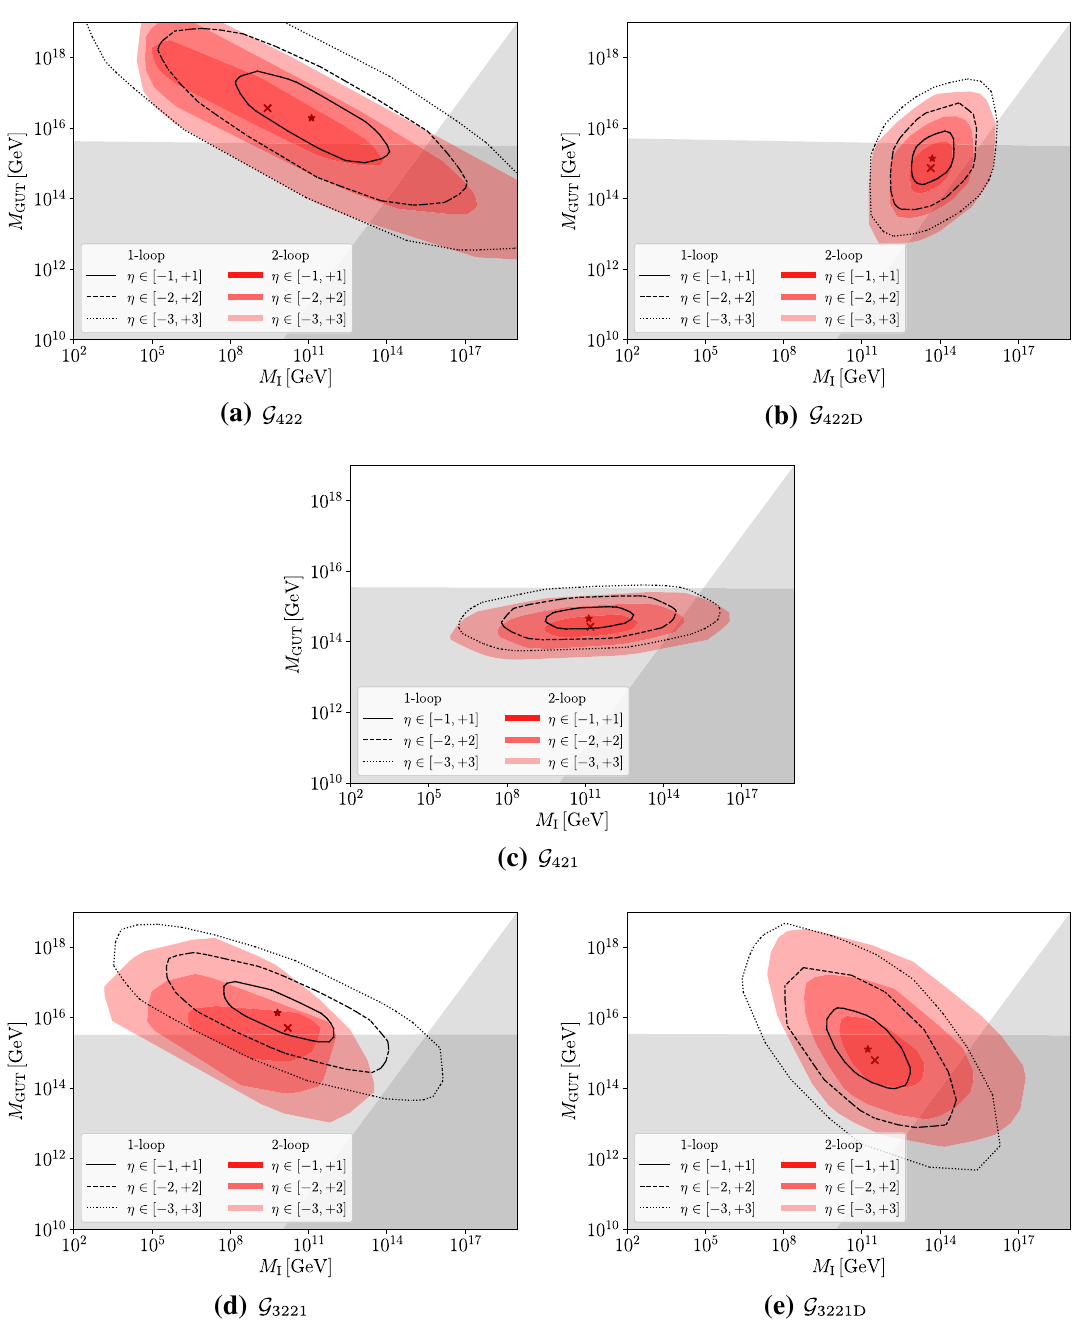
η ∈ [− 1 , + 1 ] , [− 2 , + 2 ] , and [− 3 , + 3 ] , respectively. The scales i without threshold corrections are marked with a “ × ” (“ (cid:12) ”) for the two- loop (one-loop) result. The grey shaded regions are forbidden by a too short proton lifetime and M I > M